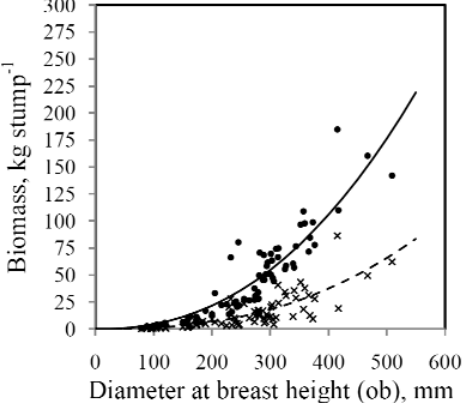
Figure 2. Dry mass per tree, kg tree − 1 , in relation to diameter at breast height (DBH; mm) of stump (— · ) and roots (--×) for sample trees from poplar stands growing on abandoned farmland.